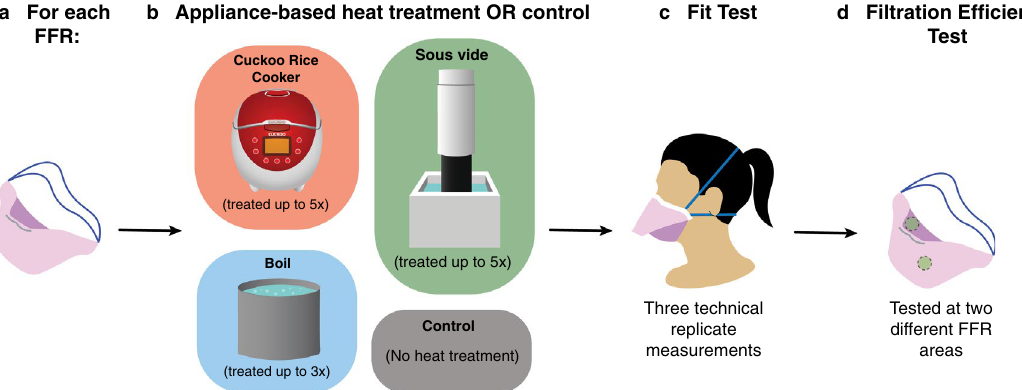
Figure 1. Experimental workflow for Halyard Fluidshield 3 (TC-84A-7521) FFRs. ( a ) Each FFR was blindly assigned to either ( b ) x round(s) of appliance-based heat treatment or to a control group. ( c ) Treatment- exposed and control FFRs were fit tested using the built-in N95 setting of a TSI PortaCount Pro + Respirator Fit Tester 8038. ( d ) The effect of appliance-based heat treatment on FFR filtration performance was evaluated for treatment and control FFRs using a modified version of the standard NIOSH